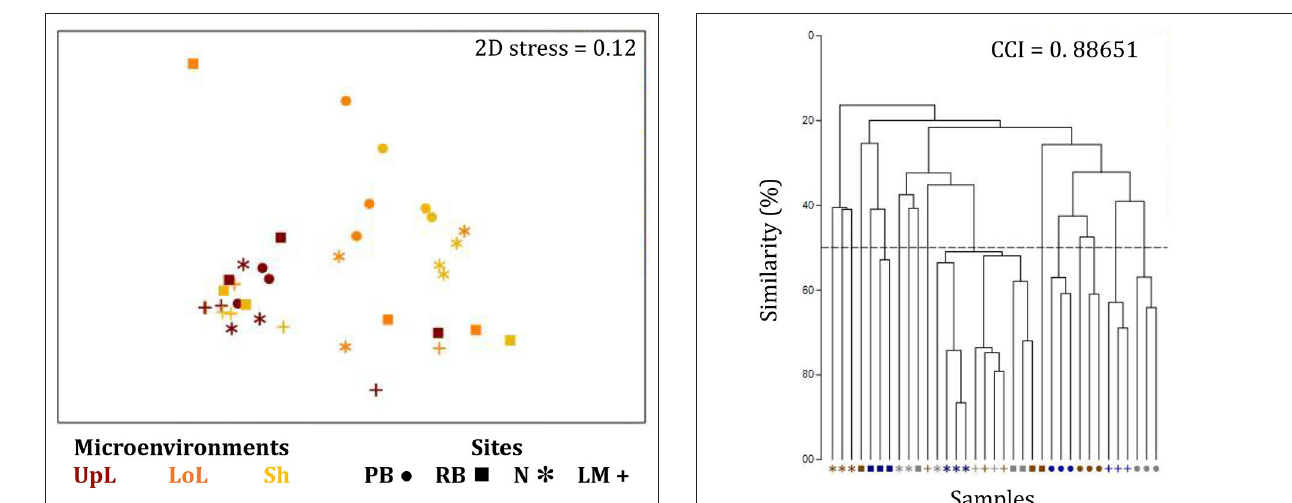
SUPPLEMENTARY FIGURE 6 | The seagrass leaf-associated microbiomes (Fungi, unrarefied data). Non-parametric multidimensional scaling (nMDS) of fungal microbiomes associated with the seagrass leaf ( n = 36), based on a lower triangular resemblance calculated with the S17 Bray–Curtis similarity measure from relative abundances of OTUs (high values down-weighted with square root). Samples are colored by microenvironment (UpL, upper leaf; LoL, lower leaf; Sh, sheath), with different shapes for sites (PB, Palm Beach; RB, Rose Bay; N, Narrabeen Lagoon; LM, Lake Macquarie). Clustering patterns by microenvironment within each site represent the level of similarity between samples based on the degree to which OTUs are shared between them. The 2D stress is shown in the upper right corner of the nMDS plot (Kruskal stress formula = 1, minimum stress = 0.01).